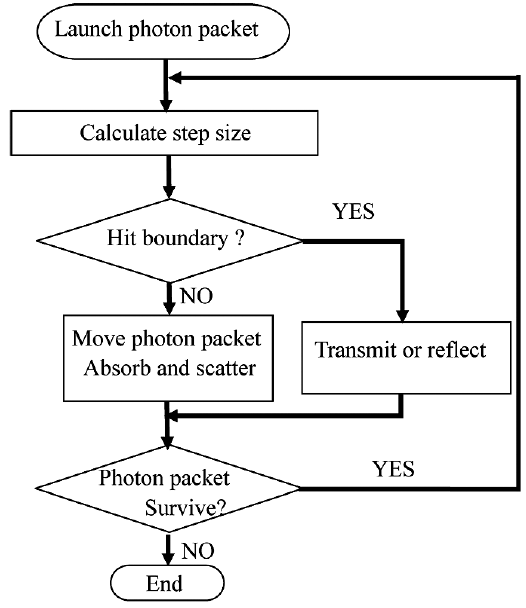
Fig. 1. A °owchart of the MC